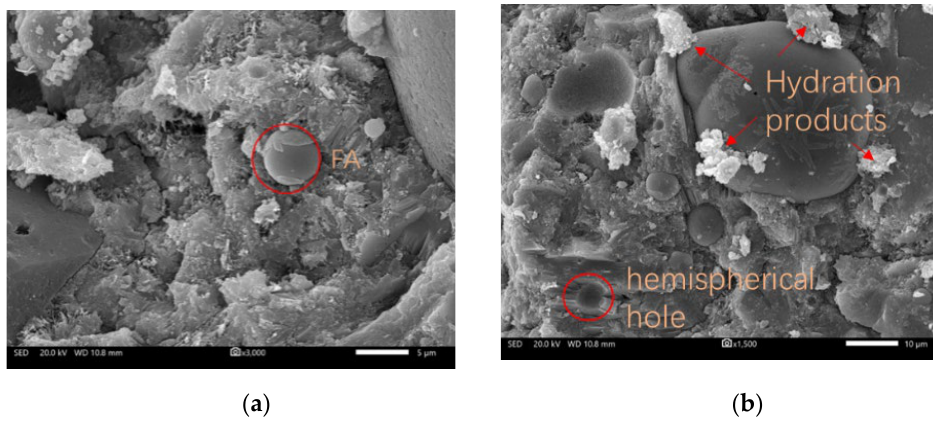
Figure 9. SEM pictures of FA25-P under the SC condition, ( a ) Microstructure and ( b ) FA particles in paste.